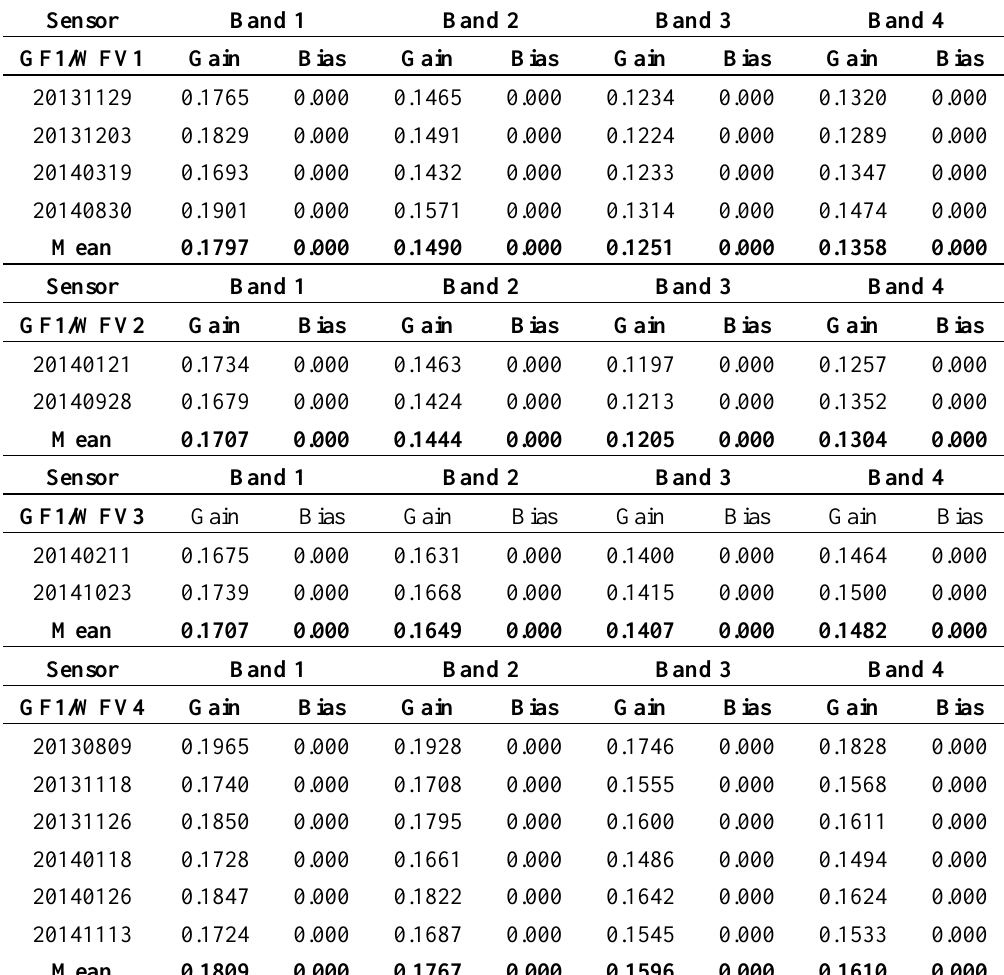
Table 11. Calibration coefficients for